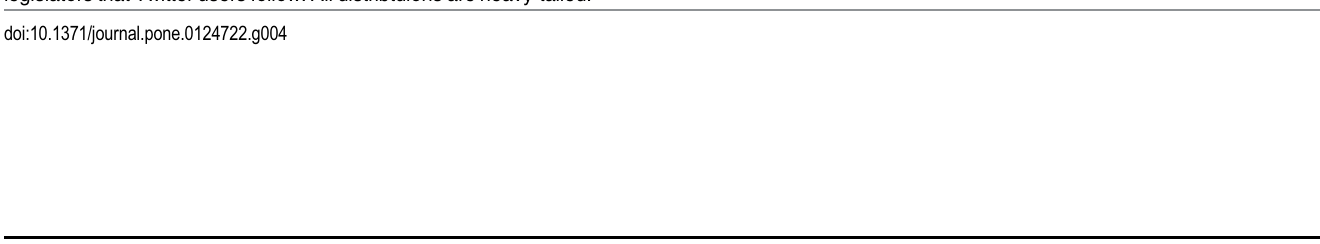
PLOS ONE | DOI:10.1371/journal.pone.0124722 April 27,